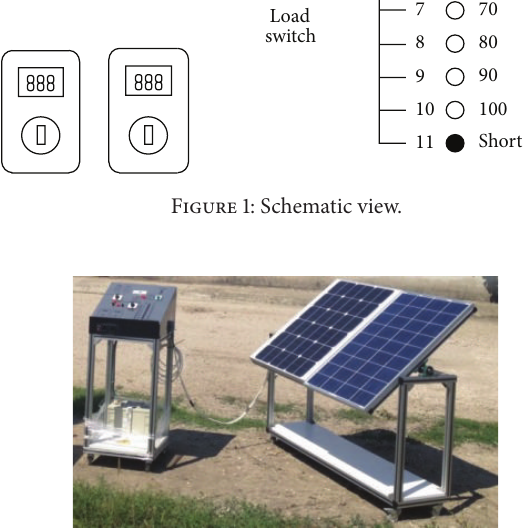
Figure 2: Photograph of